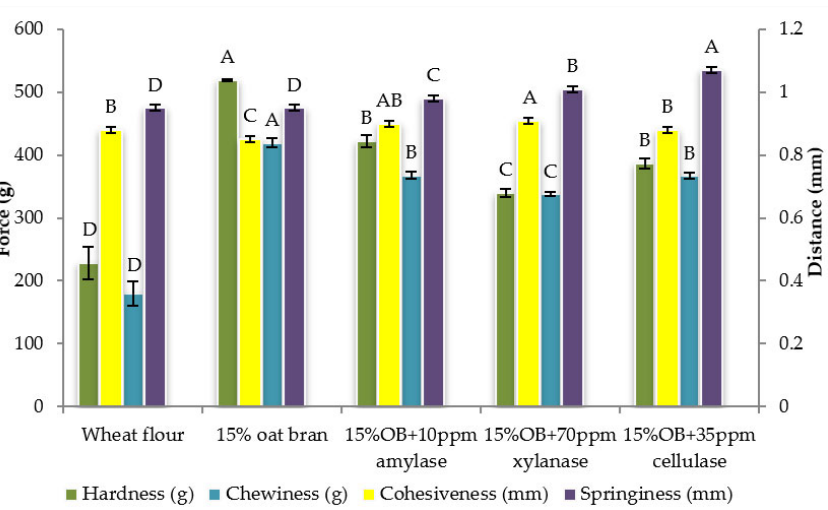
Figure 2. Textural properties of Chinese steamed bread with single enzyme. Values with different letters differ significantly ( p <